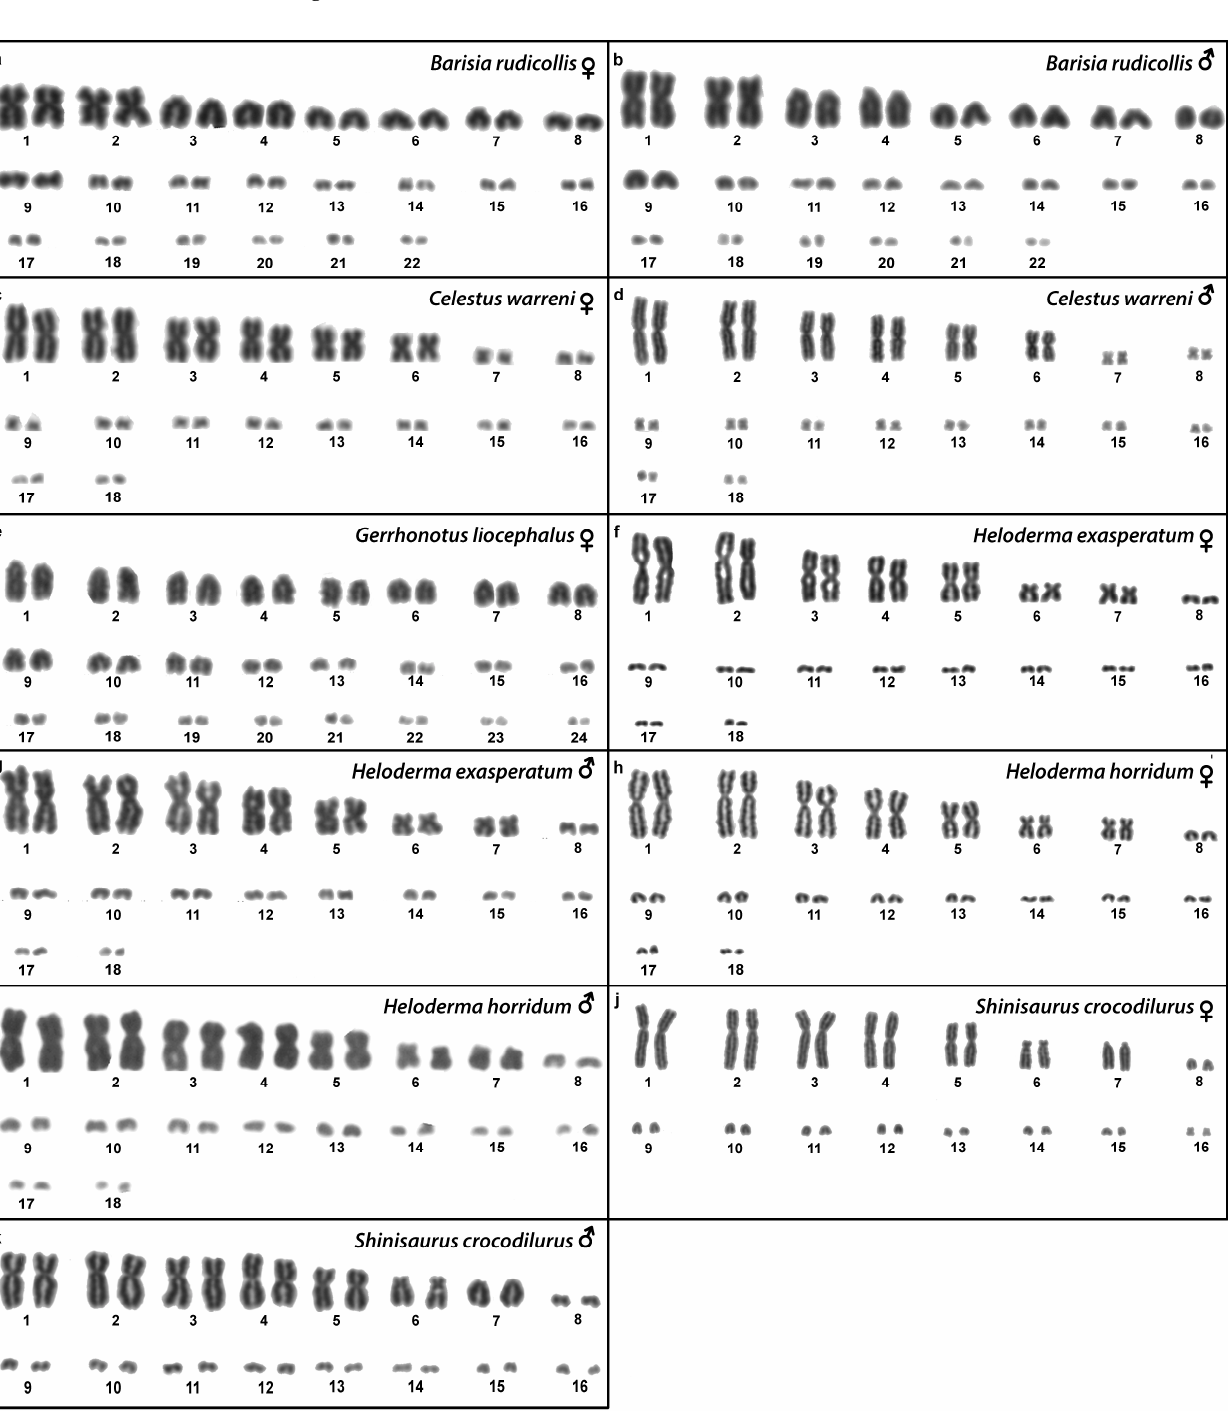
Figure 2. Giemsa-stained karyograms of Barisia rudicollis ( a , b ), Celestus warreni ( c , d ), Gerrhonotus liocephalus ( e ), Heloderma exasperatum ( f , g ), Heloderma horridum ( h , i ) and Shinisaurus crocodilurus ( j , k ).